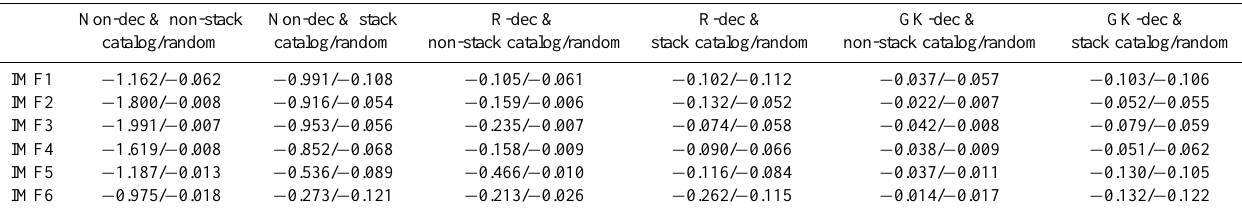
Fig. 3. (a) The first six IMFs (IMF1 to IMF6 from top to bottom) of non-stacked data of the number of daily earthquakes from the non- declustered catalog in Taiwan. The symbols indicate the clear peaks in the IMFs that are associated with large earthquakes. (b) The top panel represents the temporal variations in theoretical Earth tides at the center of Taiwan and the stacked data of daily earthquake numbers from the non-declustered catalog. The upper part of the first panel shows five sets of Earth tides with a period of 1462 days. The second to seventh panels display the IMFs (IMF1 to IMF6) that were extracted from the stacked time series. Table 1. The relative entropy values of the real data and the random data at a 95% confidence